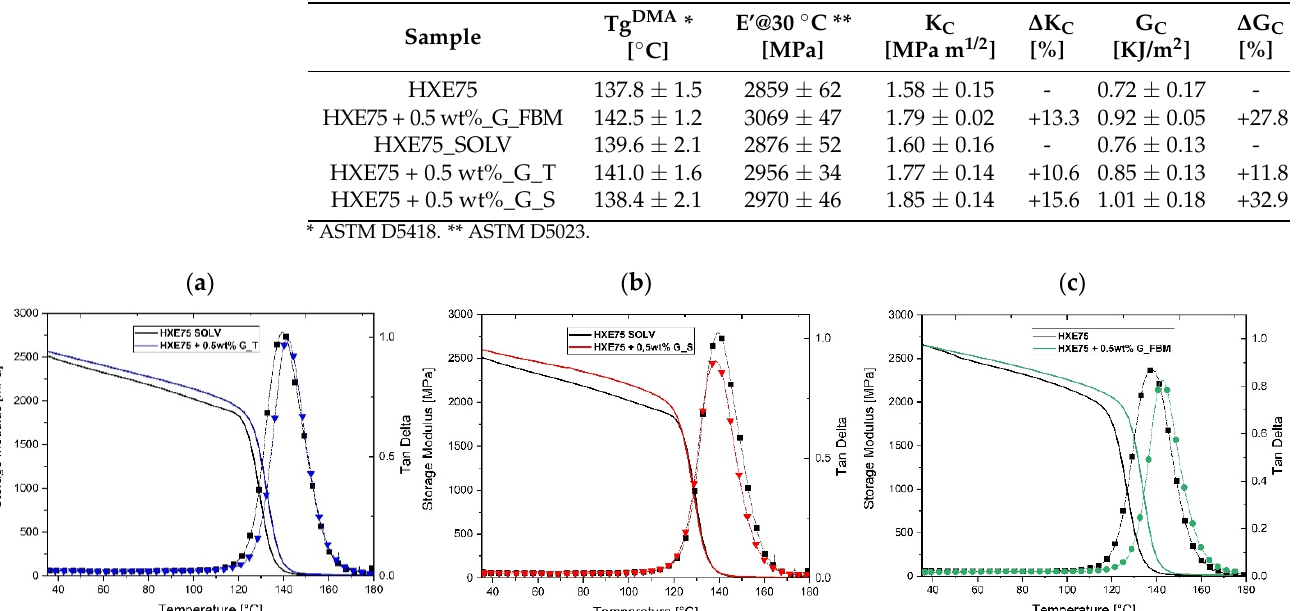
Table 3. Results of the mechanical characterization (DMA and fracture toughness) of the GNP based nanocomposites.